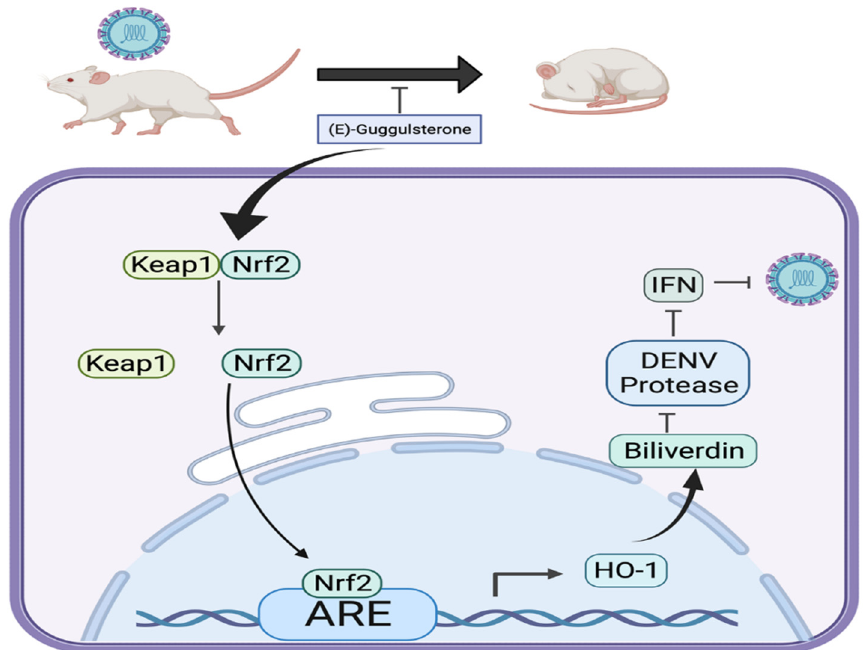
Figure 8. Graphic representation of antiviral action of (E)-guggulsterone in DENV replication. (E)- guggulsterone effectively inhibits DENV replication through the Nrf2/HO-1 signaling pathway, blocks DENV NS2B/NS3 protease activity by stimulating the antiviral IFN response, and delays DENV-induced lethality of ICR suckling